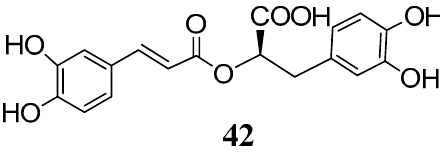
Figure 10. Structure of rosmarinic acid ( 42 ).